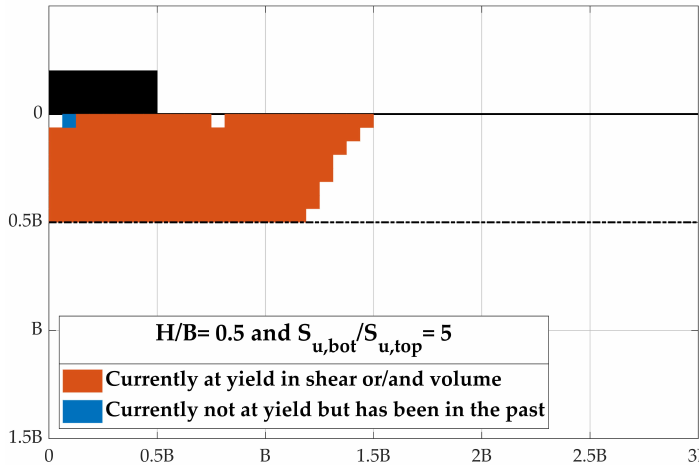
Figure 15. Comparison of bearing factors from various methods.